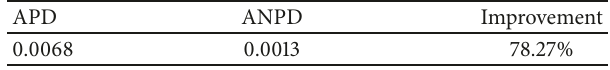
Table 3: The RMSE given by the APD and ANPD controllers. APD ANPD Improvement 0.0068 0.0013